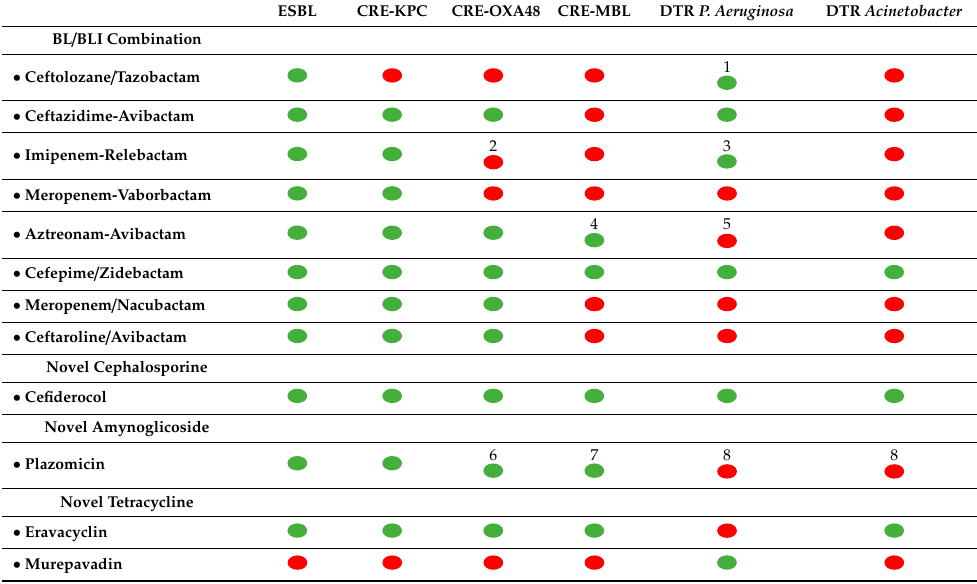
activity for carbapenemase-producing strains of CR P. aeruginosa ; 2. Very weak activity; 3. Not have activity against MBL; 4. Reduced activity against certain NDM Escherichia coli isolates; 5. Activity comparable to aztreonam alone; 6. Activity against OXA-type CREs but increased resistance is observed; 7. Not active against many NDMs; 8. Activity toward P. aeruginosa and A. baumannii is overall comparable to existing aminoglycosides (tobramycin, amikacin, gentamicin).